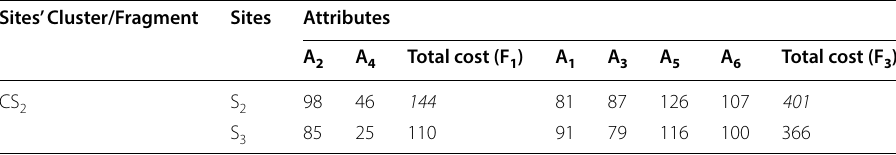
Table 20 Scenario (2)—the final allocation of data fragment Sites’ Cluster/Fragment Sites